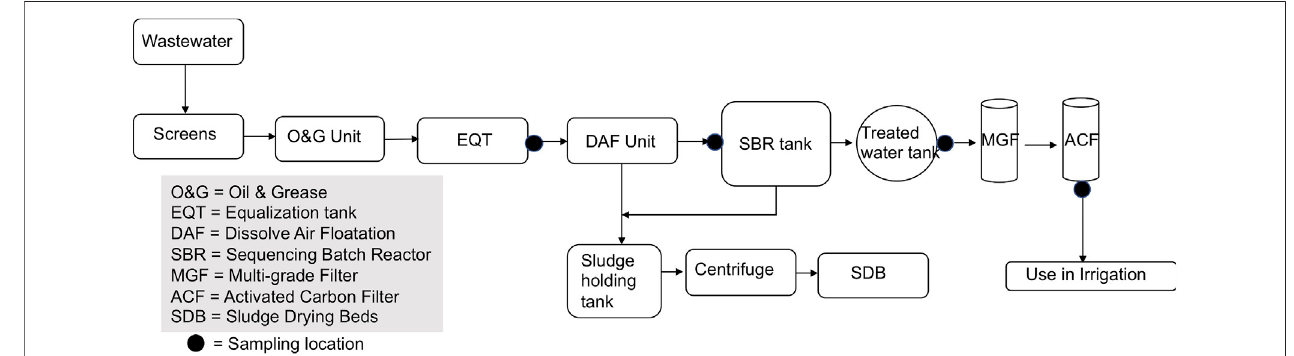
FIGURE 2 | Process fl ow diagram of ETP of Al Noor Pvt., Ltd.